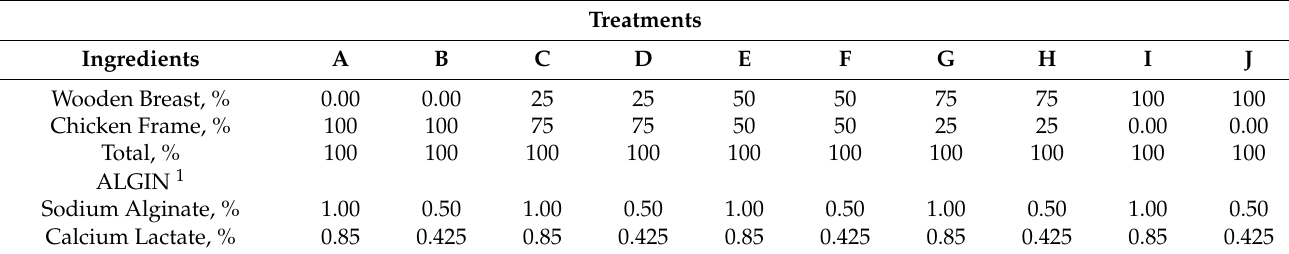
Table 1. Pet food formulations with poultry co-product and ALGIN 1 inclusion percentages.